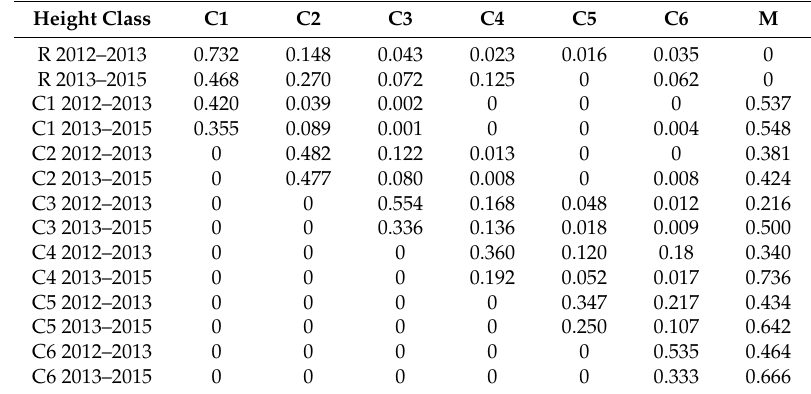
Table 3. Probabilistic transition of height (m) classes for Mora paraensis in Marac á , south-eastern Amap á , Brazil, eastern Amazon, for the period 2012 to 2013 and 2013 to 2015. Where R = Recruitment; M = Mortality; C1 (0.50–1.50 m); C2 (1.51–2.50 m); C3 (2.51–3.50 m); C4 (3.51–4.50 m); C5 (4.51–5.50 m); C6 (5.51–6.50 m).